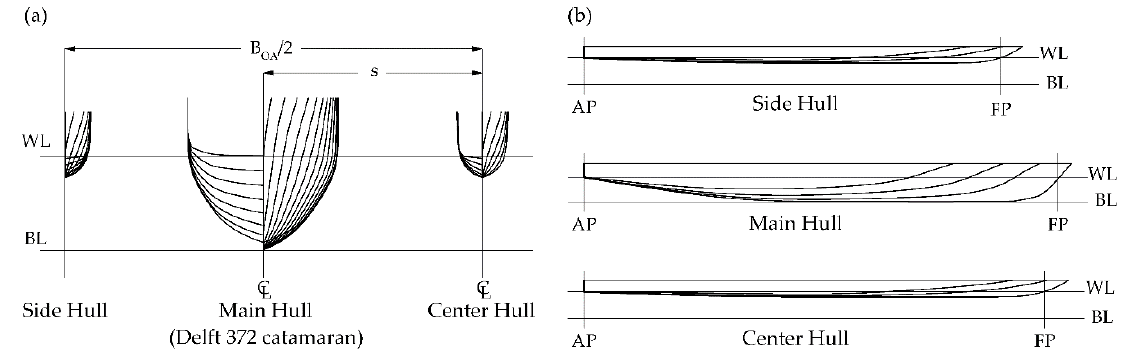
Figure 1. Lines plan of Double-M craft ( a ) Body plan ( b ) Sheer plan.